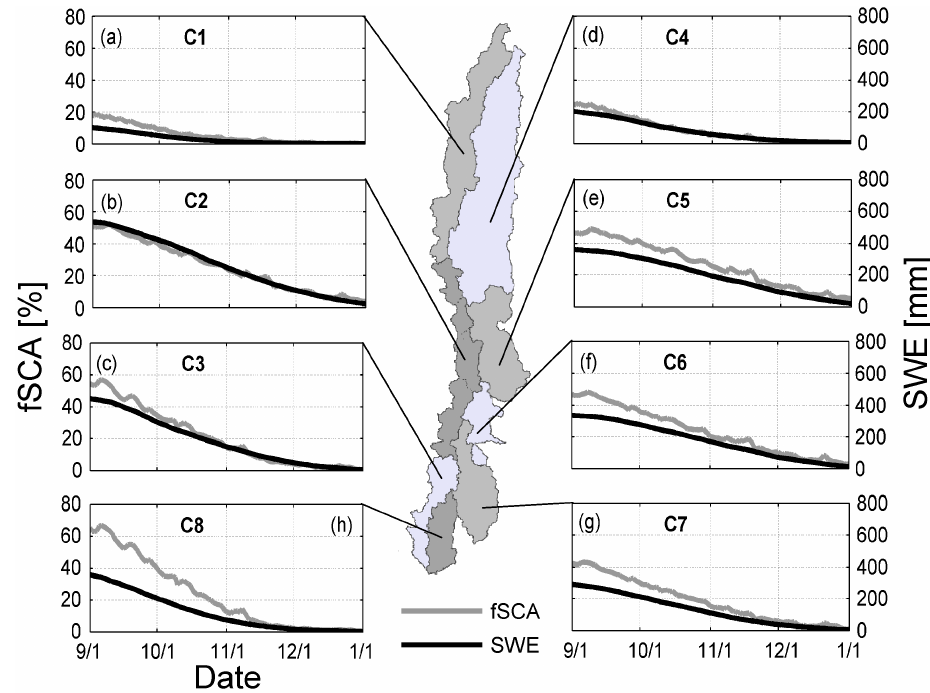
Figure 10. Average seasonal evolution of fSCA and SWE in the study region. Lower right panel shows the spatial correlation between time-averaged fSCA, SWE and specific melt-season river